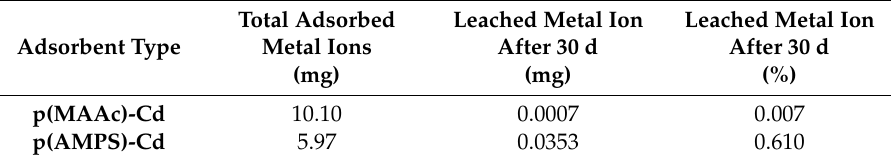
Table 4. Leaching experiment results at pH 6.5